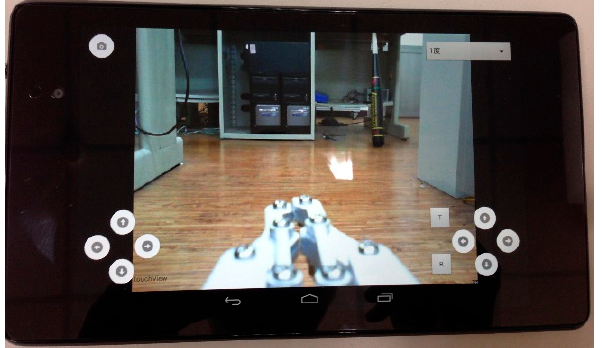
Figure 4. The control interface design.